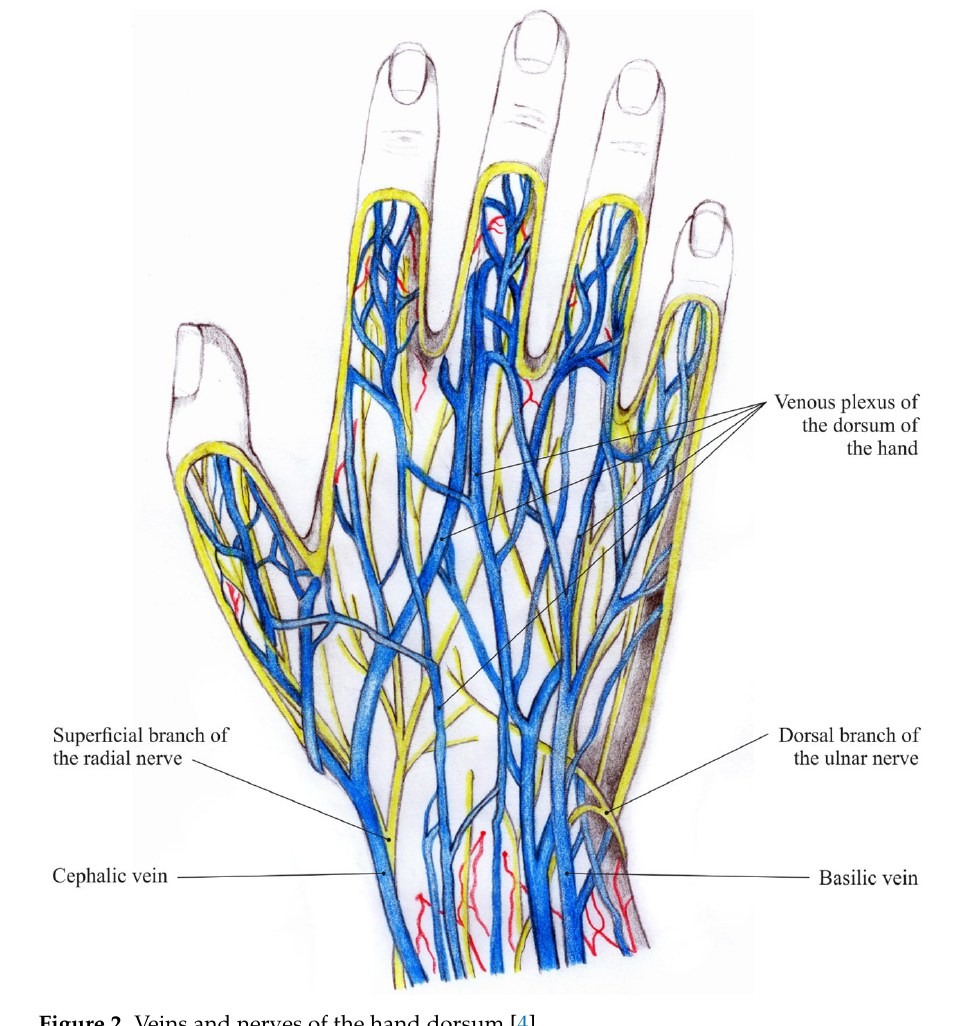
Figure 2. Veins and nerves of the hand dorsum